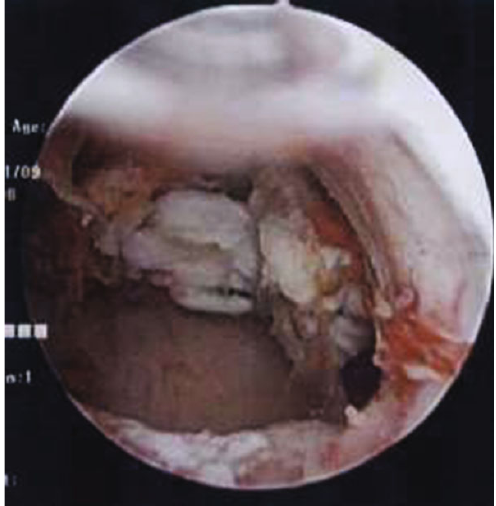
Figure 4: Hysteroscopic fi ndings. Two tumors were detected in the uterine cavity.